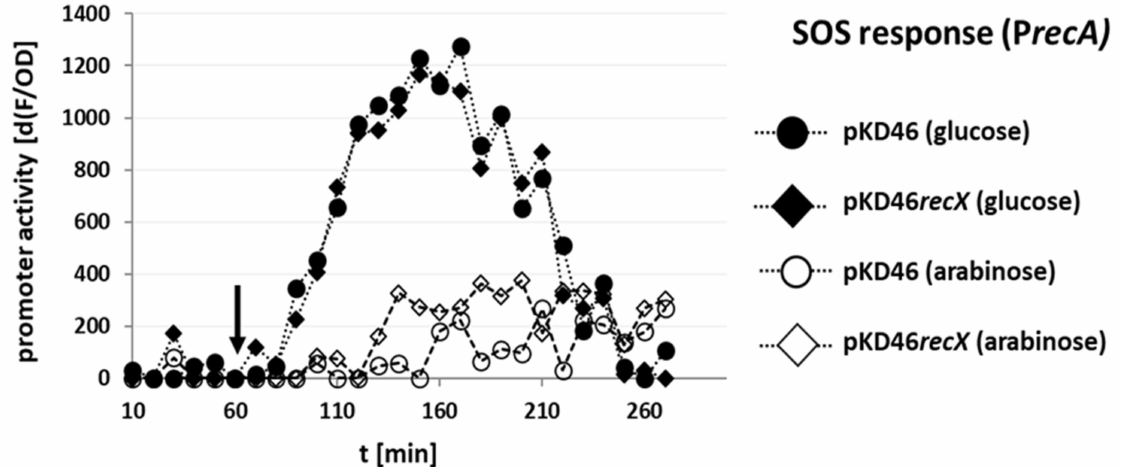
Figure 3. Sparfloxacin-dependent induction of the SOS response in E. coli MG1655 P recA SENSOR. The promoter activity of P recA as the increase of fluorescence over time in the presence of the indicated plasmid and the indicated sugar is shown. The black arrow indicates the time point of the addition of sparfloxacin (f. c. 15 µ